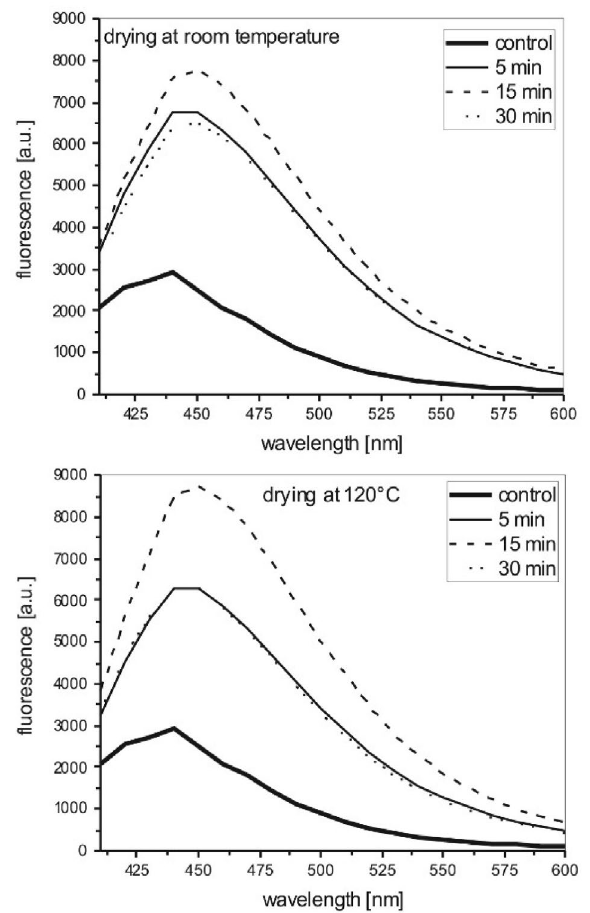
Figure 12. Fluorescence emission spectra of the prepared tex- tiles. For activation light with 380 nm is used. Presented are tex- tiles prepared with solutions realized with different process dura- tion under a process temperature of 140 °C. After solution application the textile samples are dried at room temperature or at 120